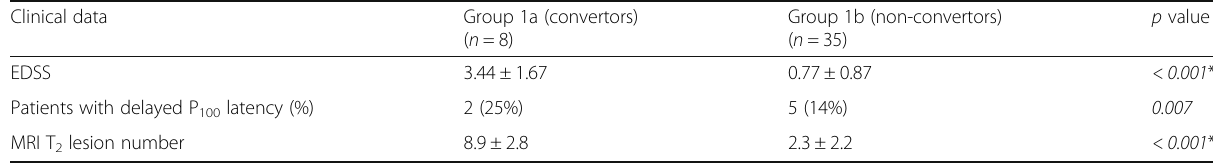
Table 2 Comparison between the convertors and non-convertors after 1-year follow-up as regard clinical, radiological and neurophysiological data Clinical